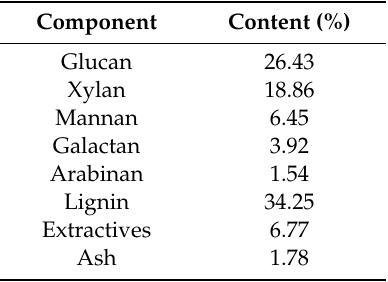
Table 1. The chemical composition of untreated